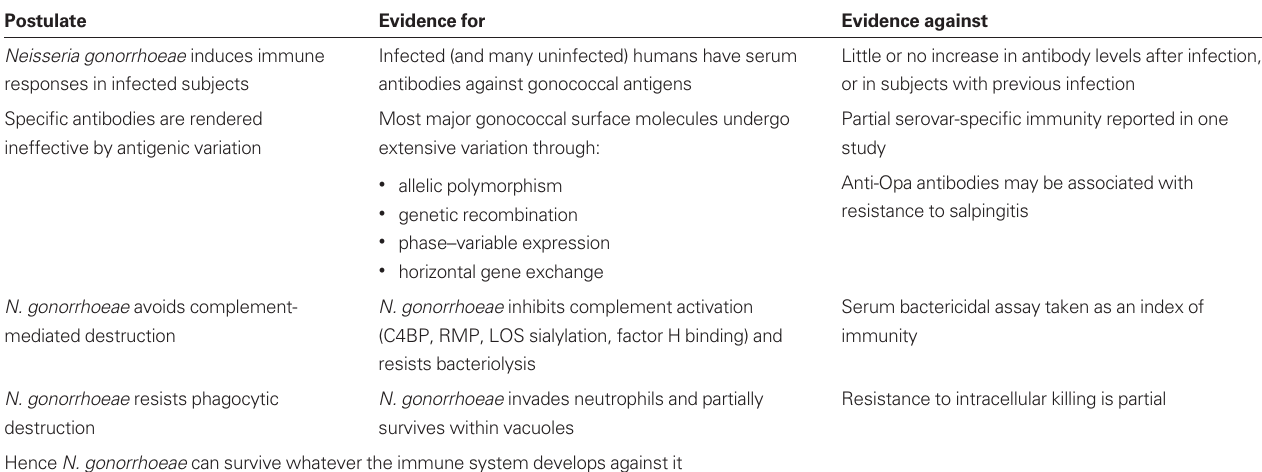
Table 1 | Conventional view of immunity to